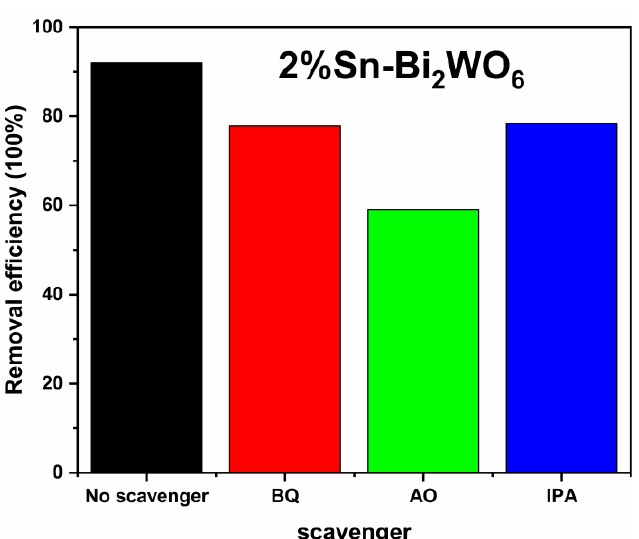
Figure 9. The degradation degrees of 2%Sn-Bi 2 WO 6 in the presence of different scavengers. According to Formulas (1) and (2), where E VB is the valence band potential, E CB is the conduction band potential, E 0 is the free electron energy on the hydrogen scale (E 0 = 4.5 eV); E g is the bandgap energy of the photocatalytic material, and X is the absolute electro- negativity of the semiconductor [46].